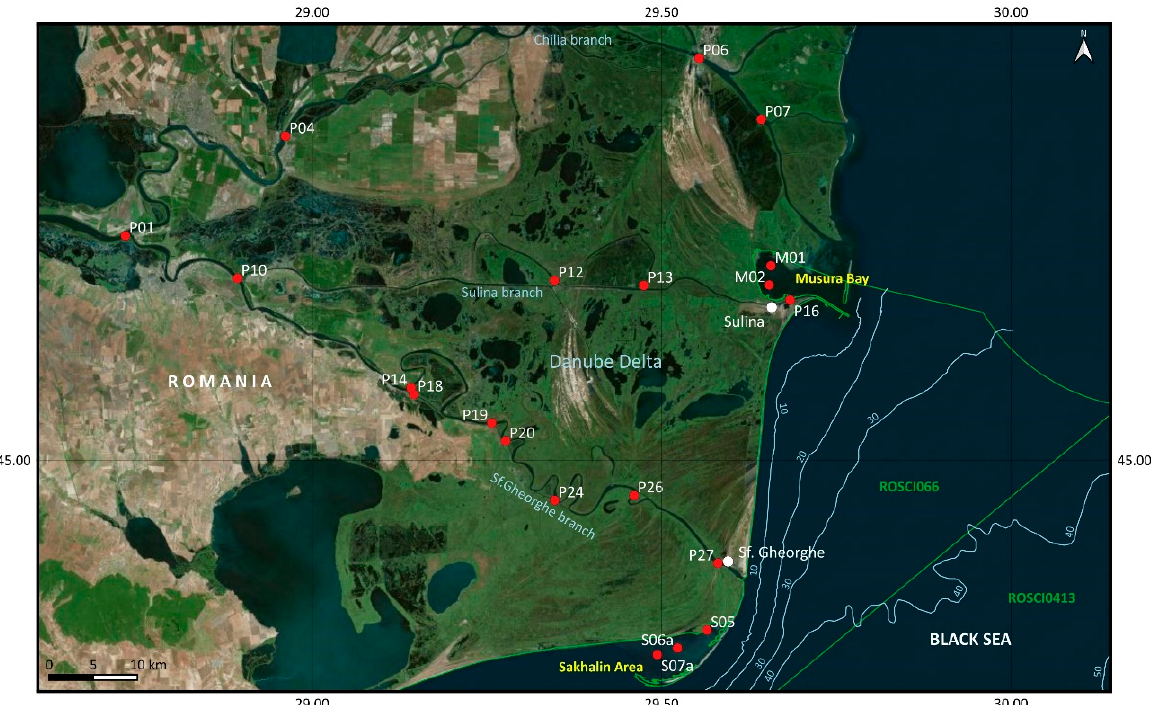
Figure 1. Sampling stations in the branches of the Danube and coastal lagoons of the Romanian Black Sea coast (Musura and Sakhalin) (green polygons ROSCI: MPA’s). Sea coast (Musura and Sakhalin) (green polygons ROSCI: